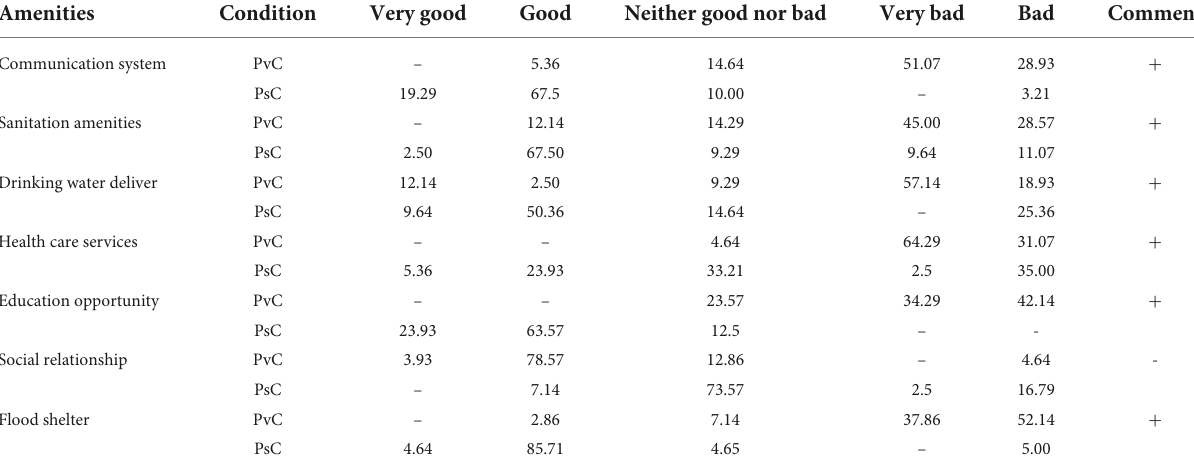
TABLE 2 Opportunities and other civic amenities in prior and current